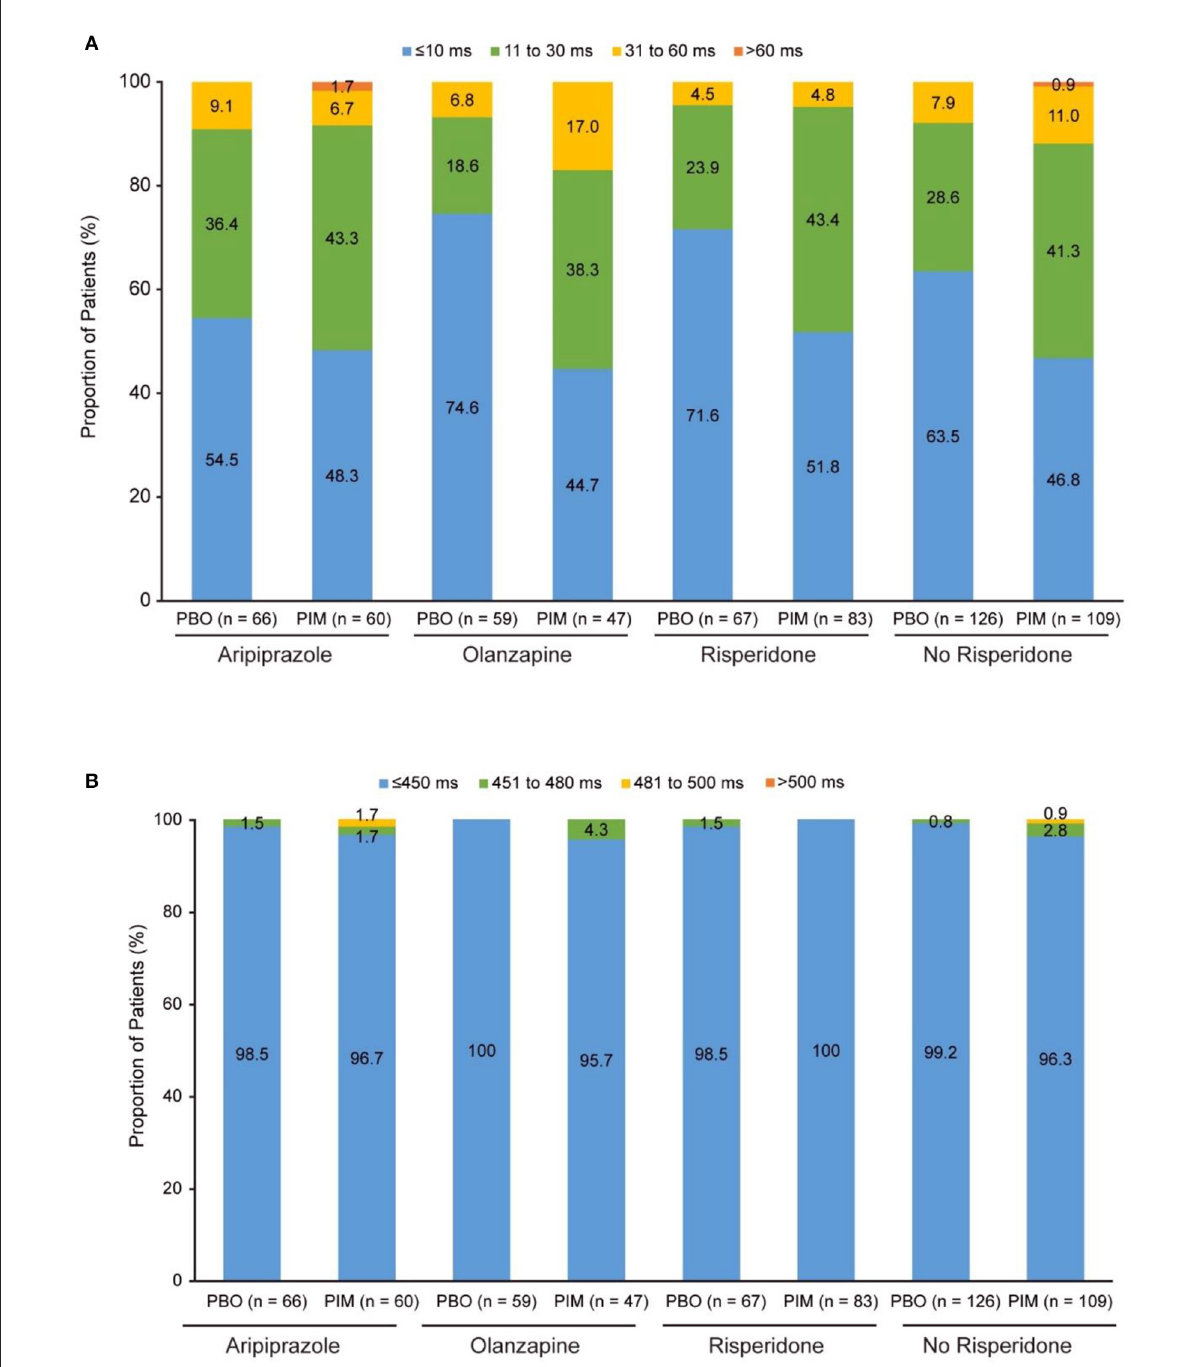
FIGURE2 ADVANCE: (A) Change in QTcF from baseline to overall postbaseline maximum and (B) QTcF overall postbaseline maximum. PBO, placebo; PIM, pimavanserin; QTcF, QT interval using Fridericia’s correction method.